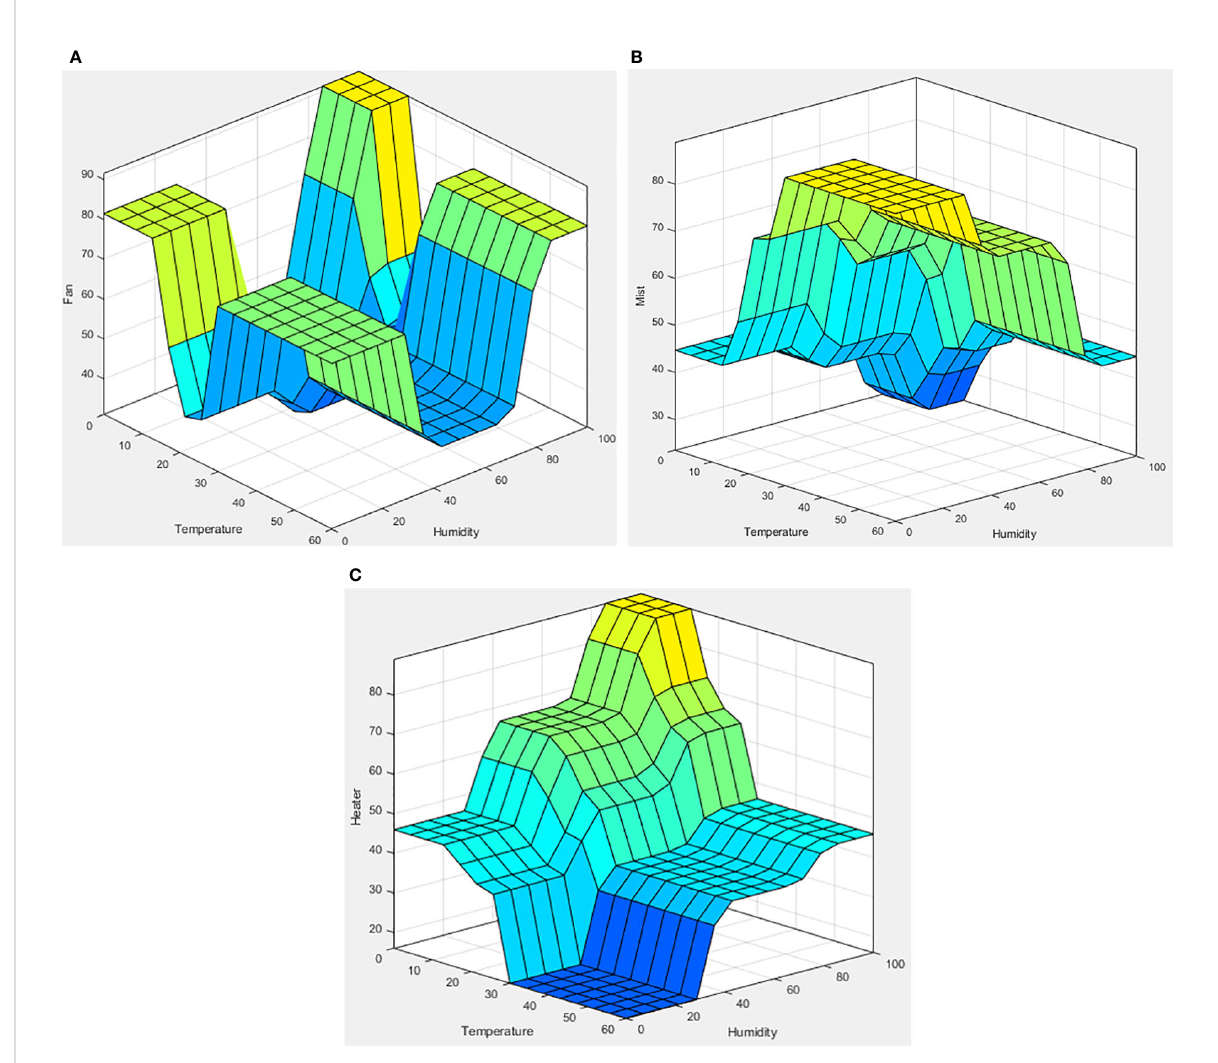
FIGURE 8 Surface view of the fuzzy logic simulation. (A) Fan, (B) humidi fi er, and (C) heaters (heater 1 and heater